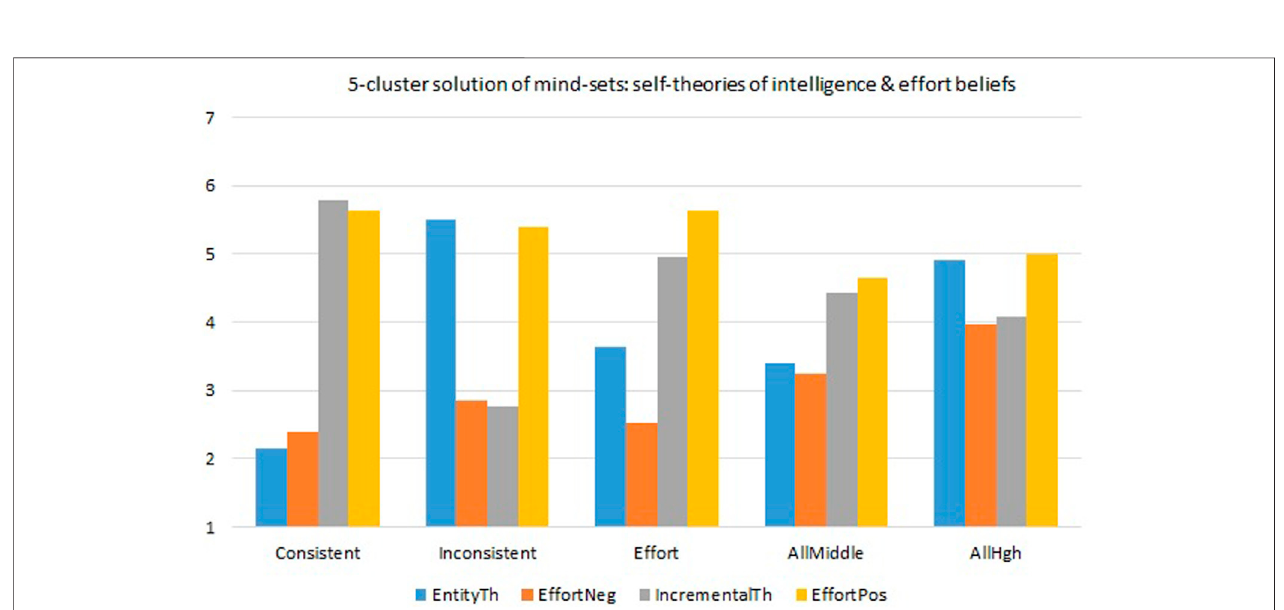
FIGURE 1 | Cluster means of EntityTheory, EffortNegative, IncrementalTheory and EffortPositive of the fi ve mindset pro fi les Consistent , Inconsistent , Effort, AllMiddle , and AllHigh .